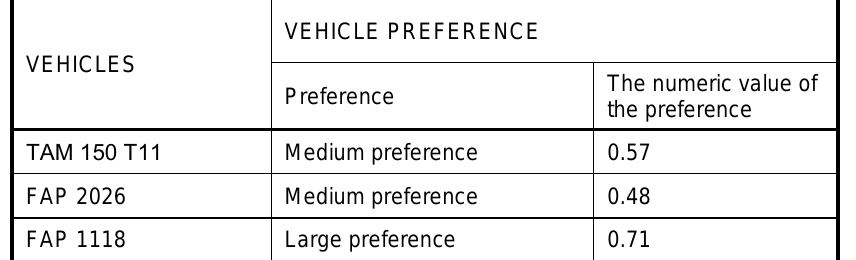
Рис. 14 – Отображение выходных значений из нечеткой системы Table 9 – Output values from the fuzzy system - Vehicle preference Таблица 9 – Выходные значения из нечеткой системы - Предпочтение транспортного средства Табела 9 – Излазне вредности из fuzzy система – преференција према возилу